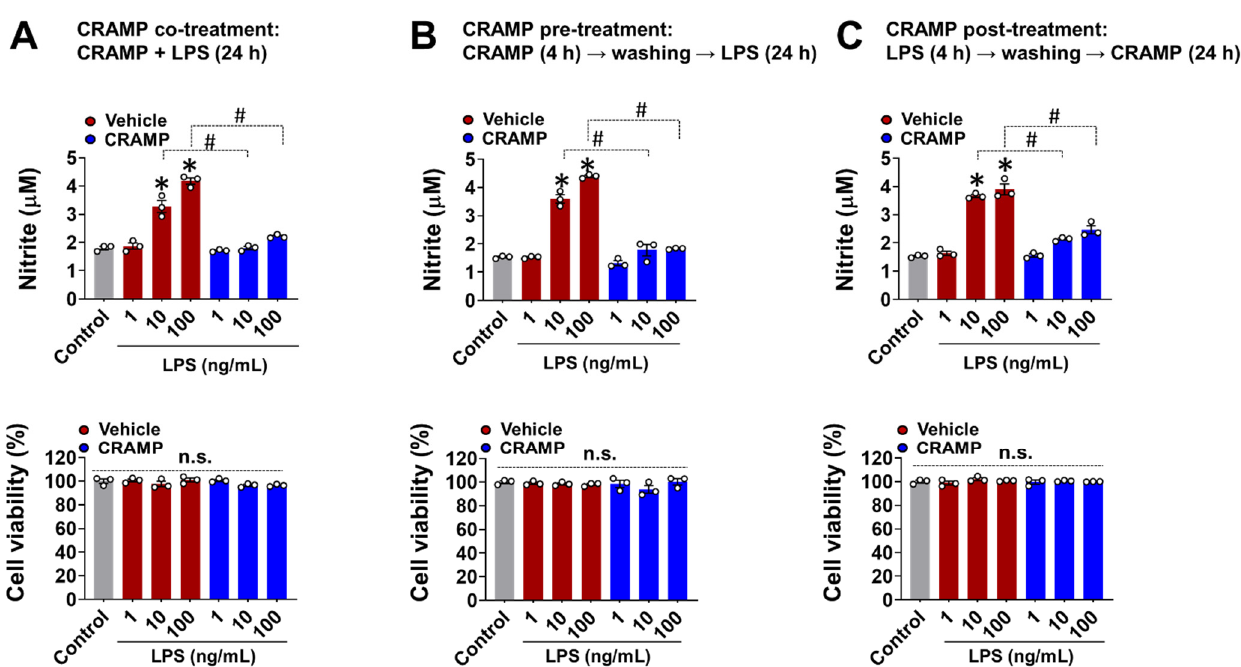
Figure 2. Effect of different CRAMP peptide treatment conditions on NO production in LPS-treated BV-2 microglial cells. The Griess assay show that CRAMP peptide treatment (30 µg/mL) attenuates LPS-induced NO production in BV-2 microglial in different experimental settings: ( A ), co-treatment; ( B ), pre-treatment; ( C ), post-treatment. MTT assay was utilized to assess cell viability, which showed no significant difference between treatment groups. Data are mean ± SEM; n = 3; * p < 0.05 versus control; # p < 0.05 between the specified groups. One-way ANOVA with Tukey’s post hoc test. n.s., not significant.